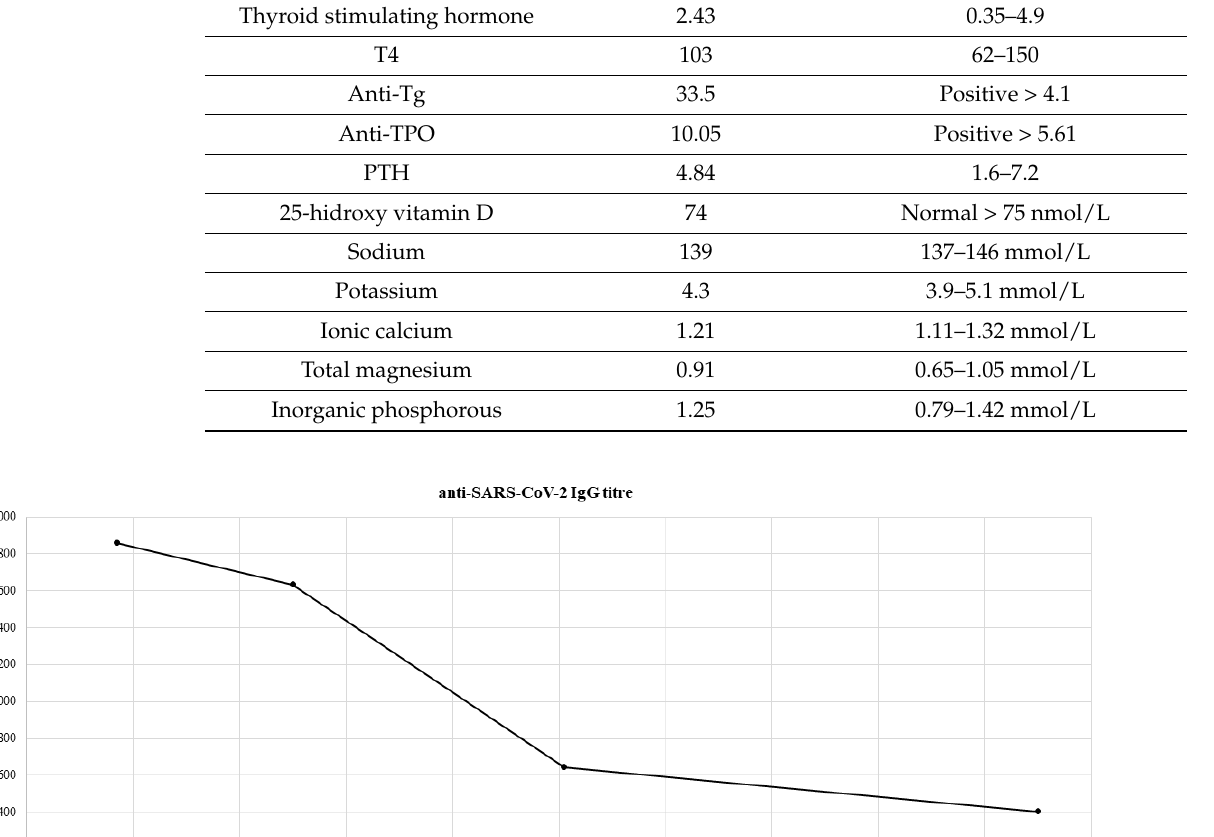
Table 1. Laboratory result summary which includes thyroid function tests and antibody titers against thyroglobulin (anti-Tg) and thyroid peroxidase (anti-TPO), as well as parathyroid hormone (PTH), vitamin D and serum electrolyte statuses. Blood was drawn on 10 June 2021. 149 Days Post Vaccination